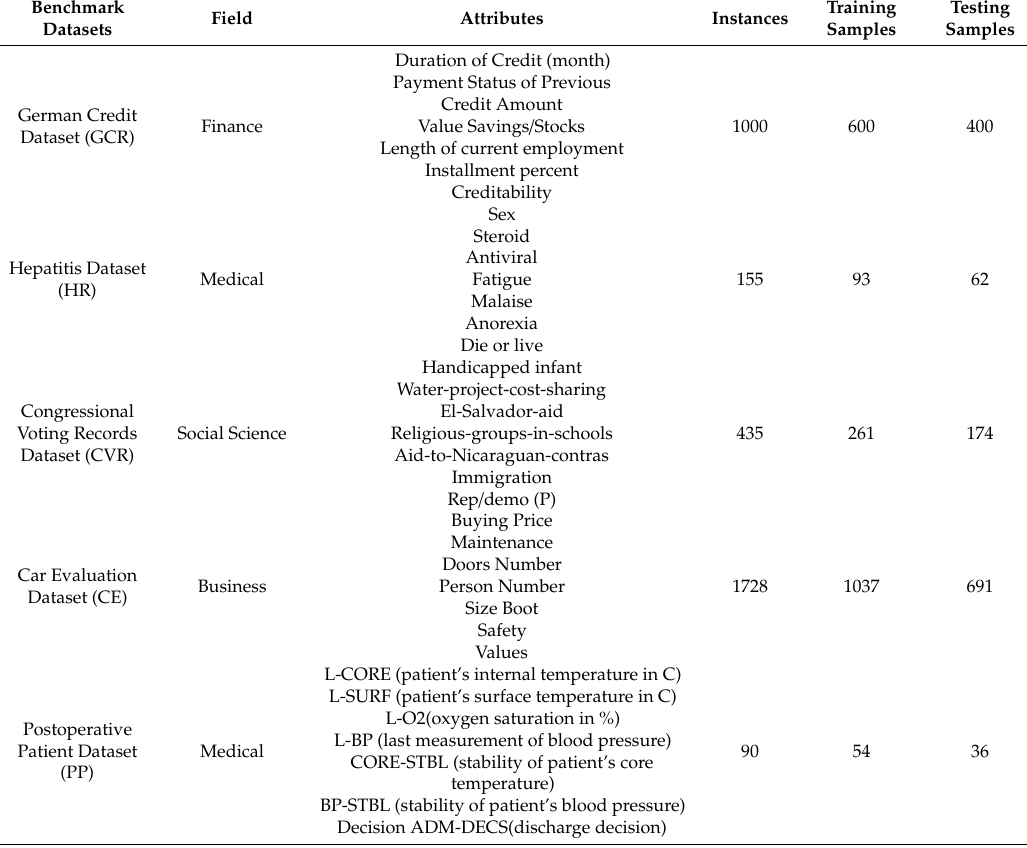
Table 2. List of Benchmark Datasets Information from UCI